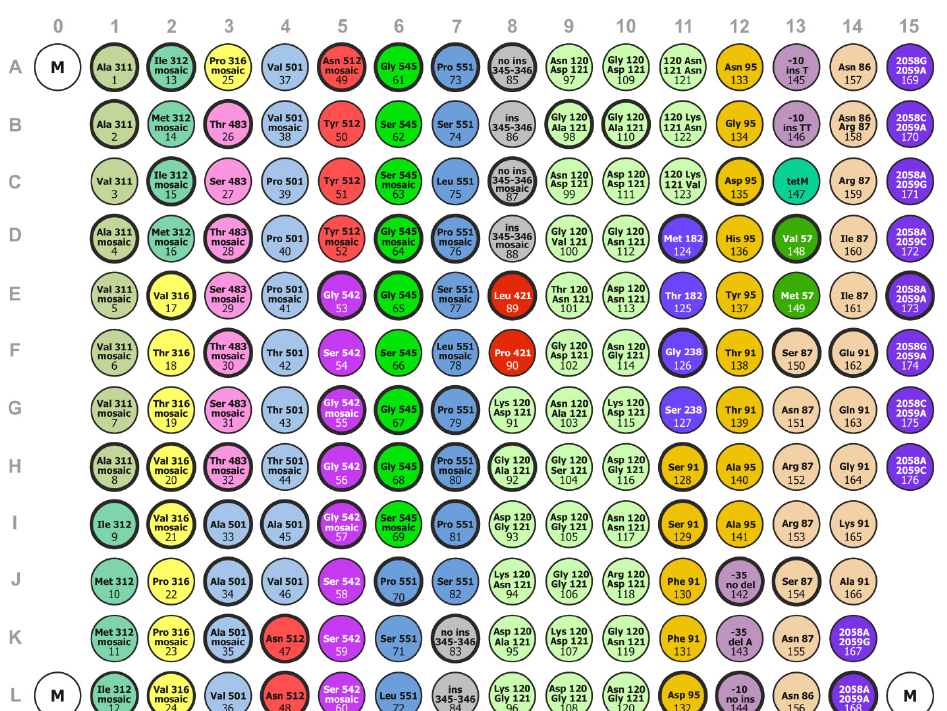
Figure 1. Configuration of the microarray for detecting mutations associated with drug resistance of N. gonorrhoeae . Circles representing elements containing probes with sequences that do not contain mutations have a bold outline. Element groups (highlighted in different colors): elements 1–8: